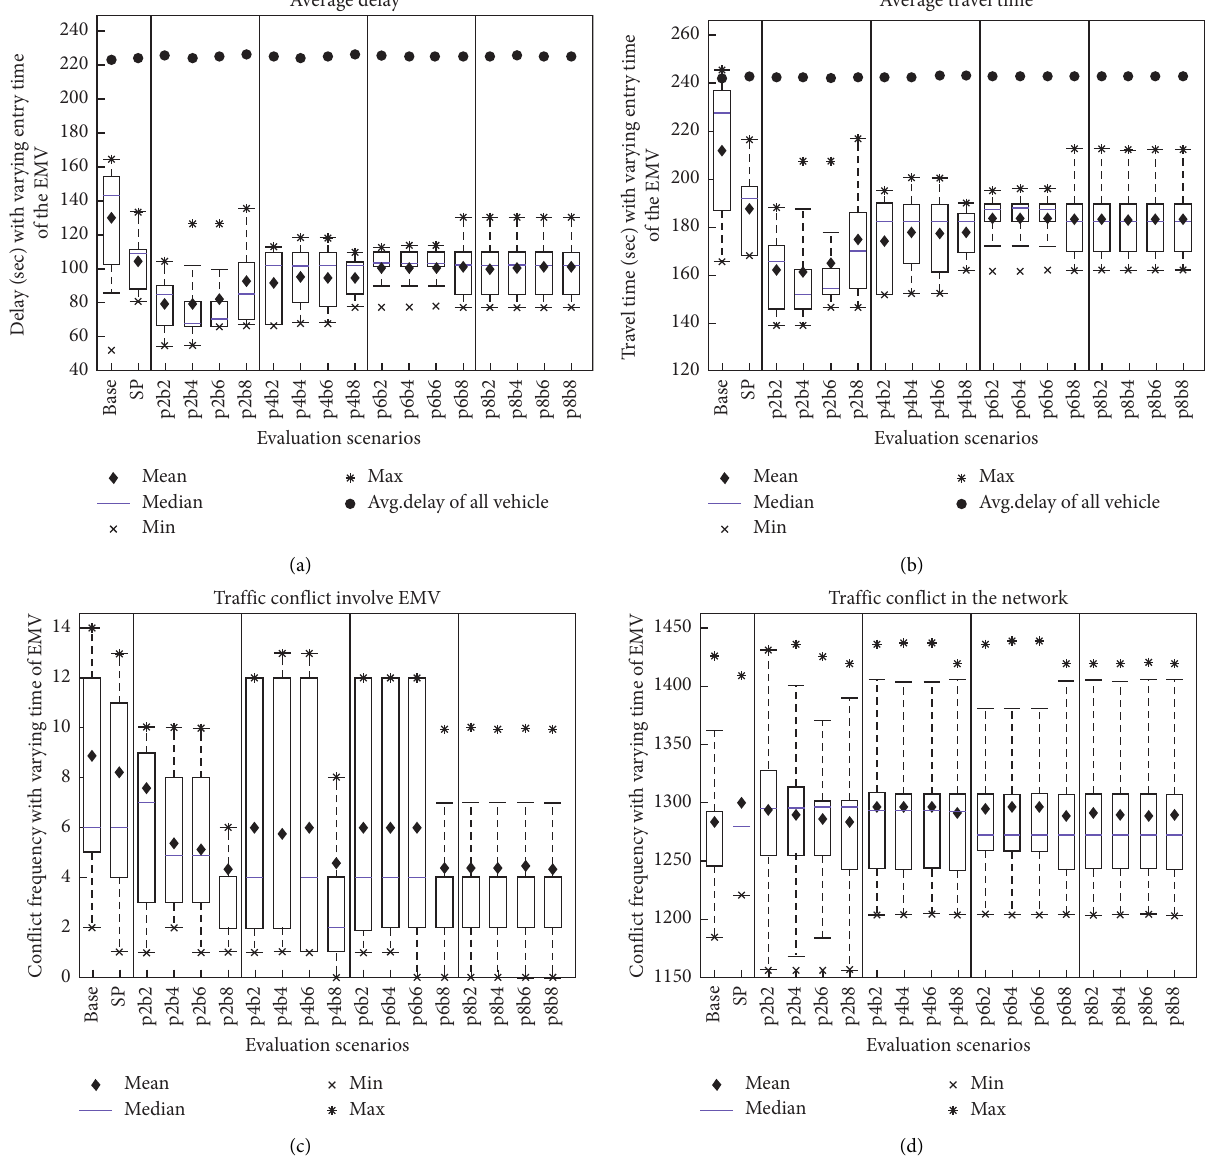
Figure 6: Safety and mobility assessment results. (a) Mobility measure, delay. (b) Mobility measure, travel time. (c) Safety measure, network-wide. (d) Safety measure, only